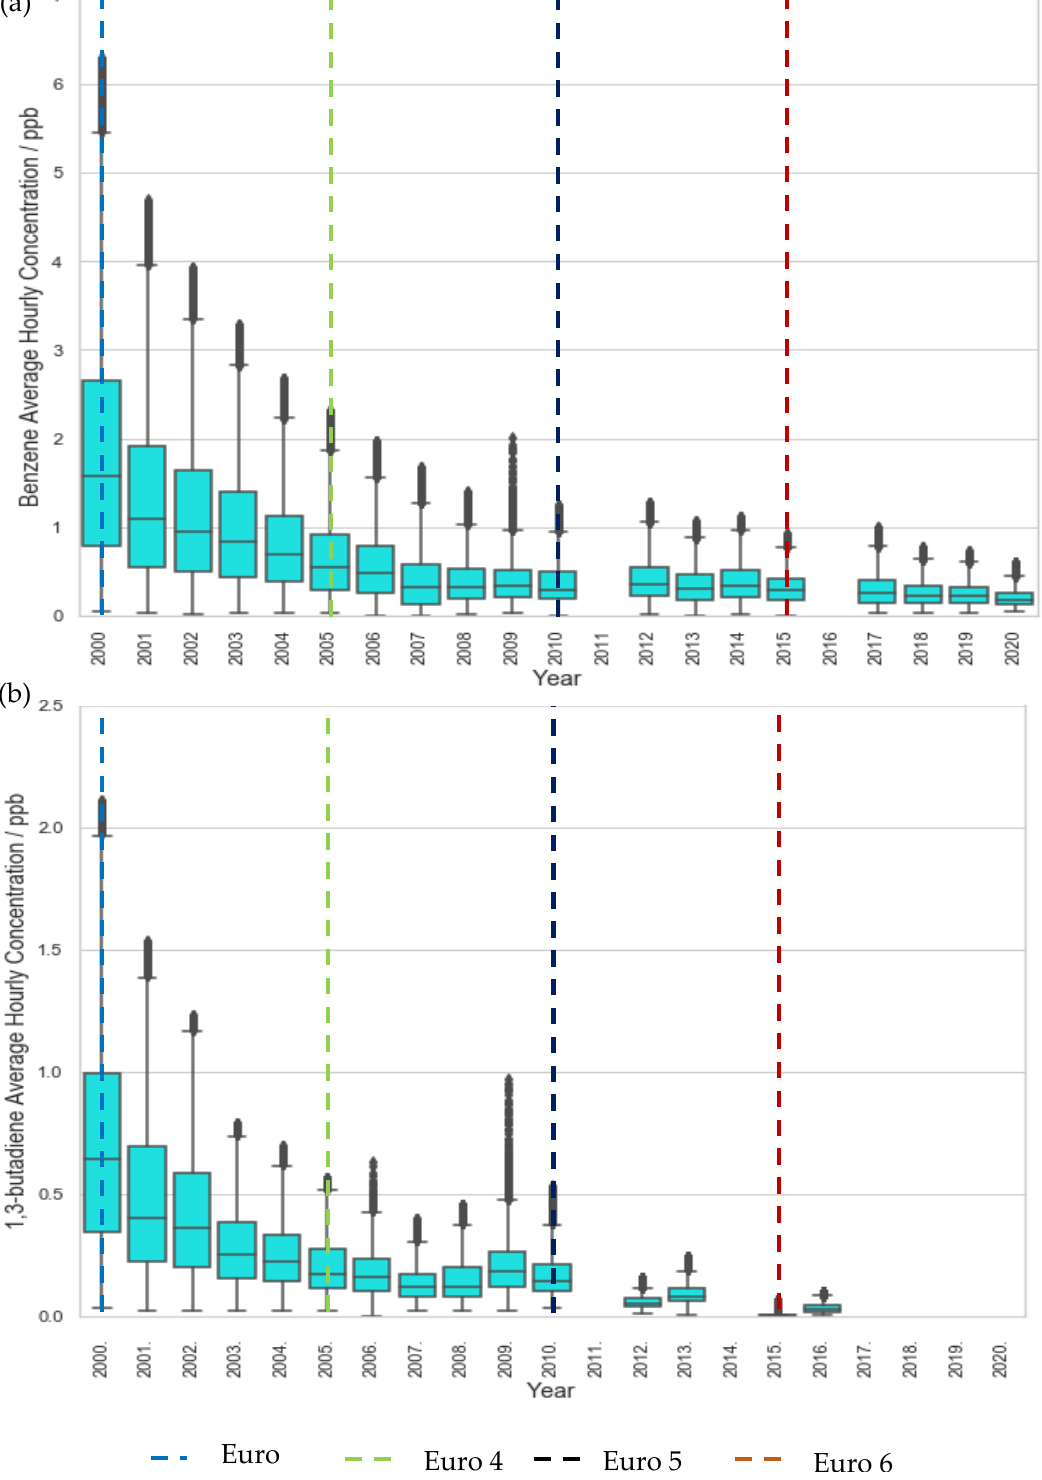
Figure 1. Trends in hourly-average pollutant concentration at the traffic site, LMR over the period 2000 – 2020 ( a ) benzene and ( b ) 1,3 butadiene. Error bars represent the 95% confidence level in pollutant concentration. Vertical lines represent implementation year of each relevant Euro control. Years with data coverage below 70% were omitted from analysis to avoid seasonal skewing (see Appendix A for data coverage representation).